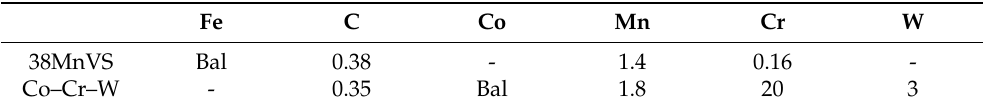
Table 1. Chemical composition of the substrate and powders used in the simulation [18] (Reprinted with permission from ref. [18]. Copyright 2017